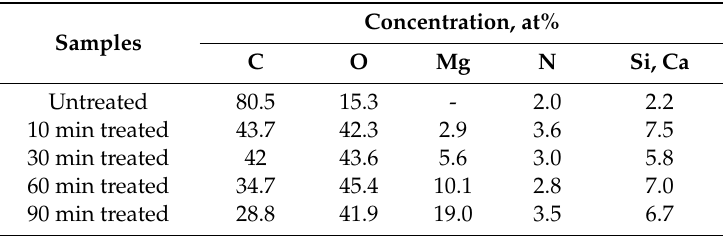
Table 1. Concentrations of elemental composition (up to 10 nm) before and after the plasma treatment.